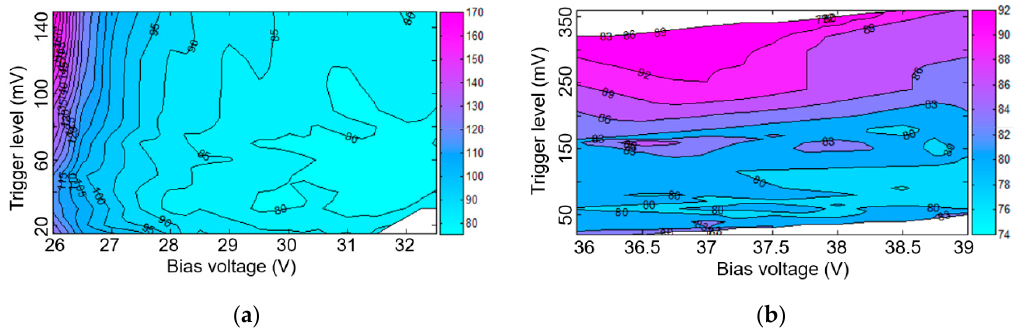
Figure 7. Contour plots of the FWHM CTR. ( a ) SensL J-series SiPMs; ( b ) AdvanSiD NUV HD SiPMs.